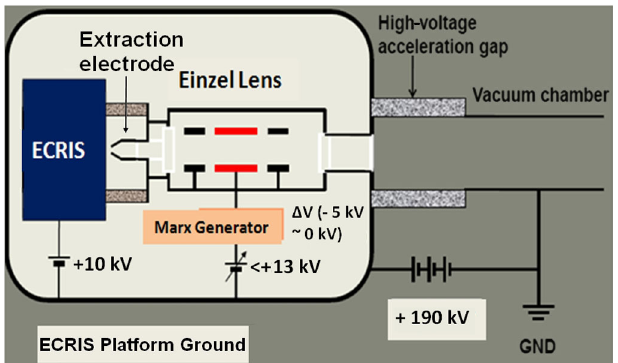
FIG. 5. Schematic view of ECRIS with the extraction system, the Einzel lens and the post-acceleration column on HVP with a voltage of 190